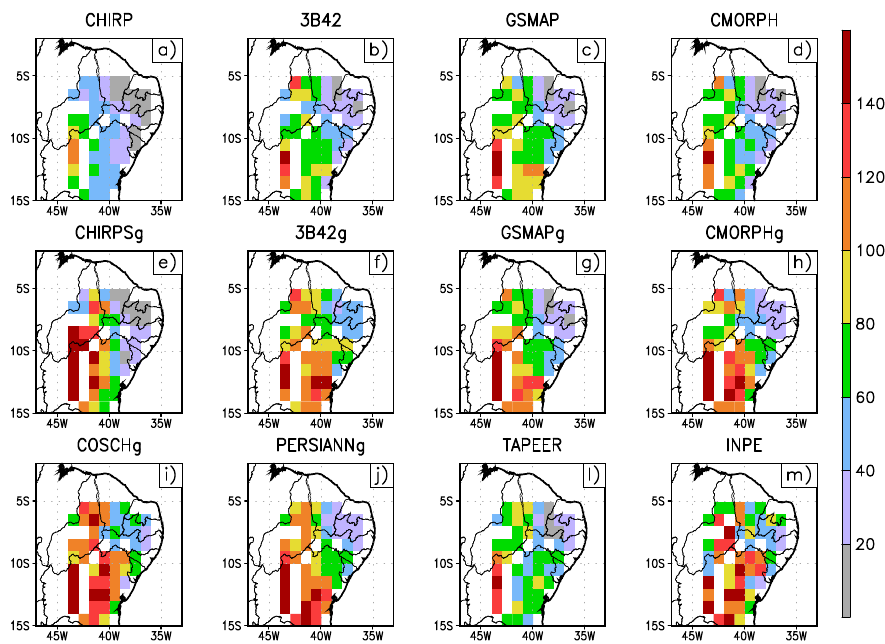
Figure 13. Case of extreme precipitation occurred over the Northeastern region of Brazil (R3) from 20 January 2016 to 24 January 2016 ( a – m